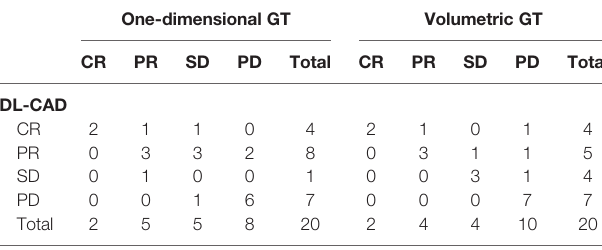
TABLE 2 | Agreement in the response assessment in neuro-oncology brain metastases (RANO-BM) criteria. One-dimensional GT Volumetric GT